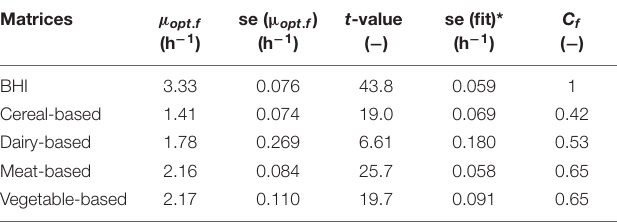
TABLE 3 | Estimated µ opt . food values and the derived correction factors for the tested matrices.